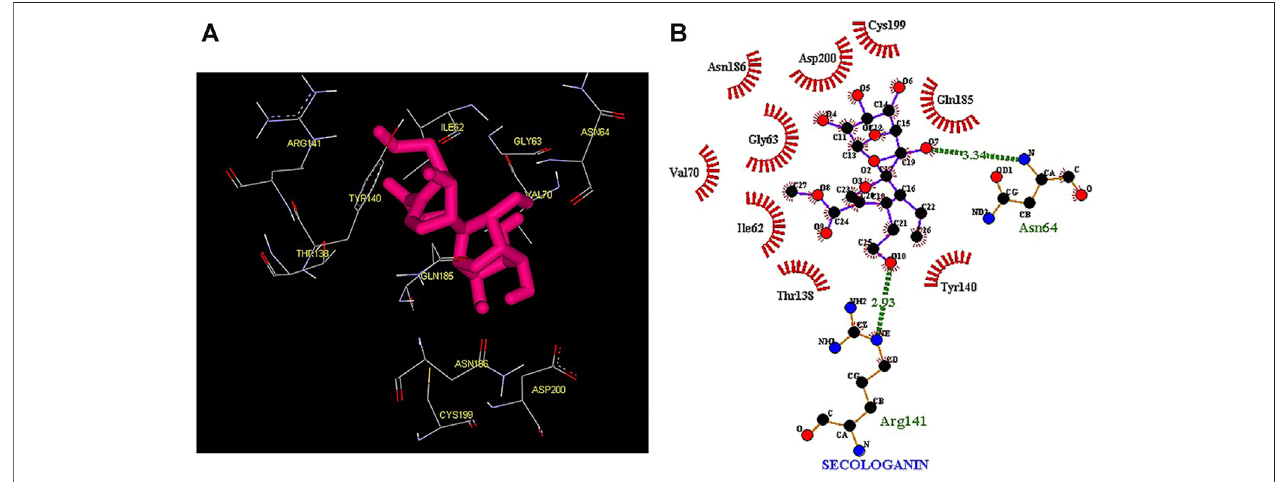
TABLE 3 | The before and after simulation of protein – ligand interaction residues. Compound